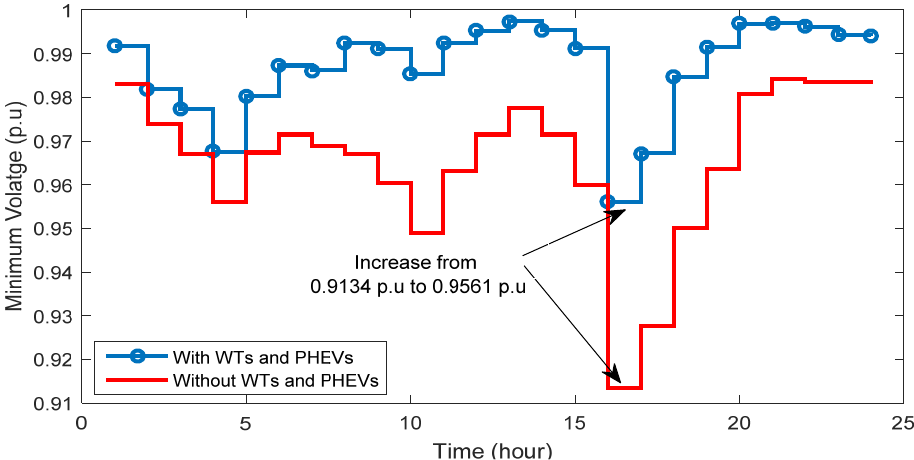
Figure 11. Minimum voltage with and without OSPF via the AOA for 24 h.